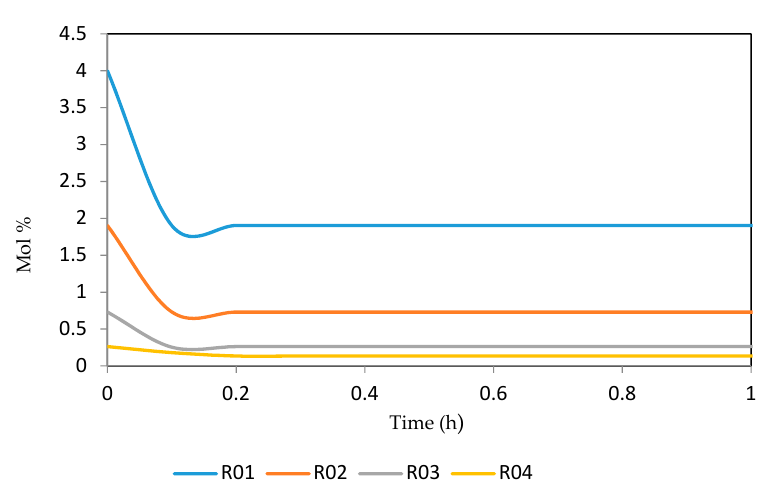
Figure 25. Dynamic behaviour of N 10 in the four reactors.